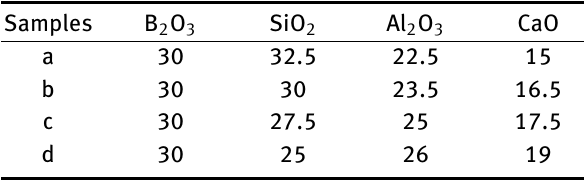
Table 1: Chemical constitution of slag system(wt.%)